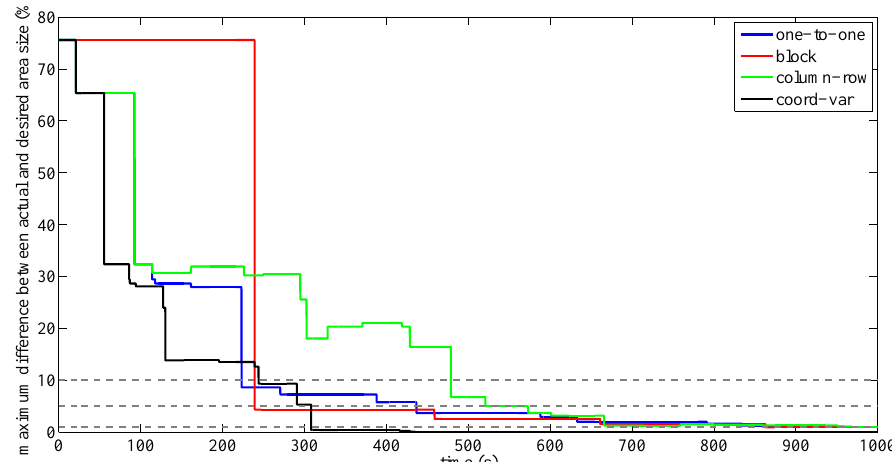
Figure 9. Evolution along the time of the maximum difference between the assigned area and the optimal one, using different coordination methods. The gray dashed lines determine a maximum relative difference of 10%, 5% and 1%